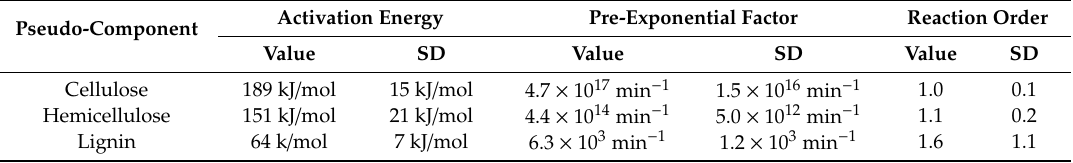
Table 2. Thermal degradation characteristics of solid digestate at di ff erent heating rates.